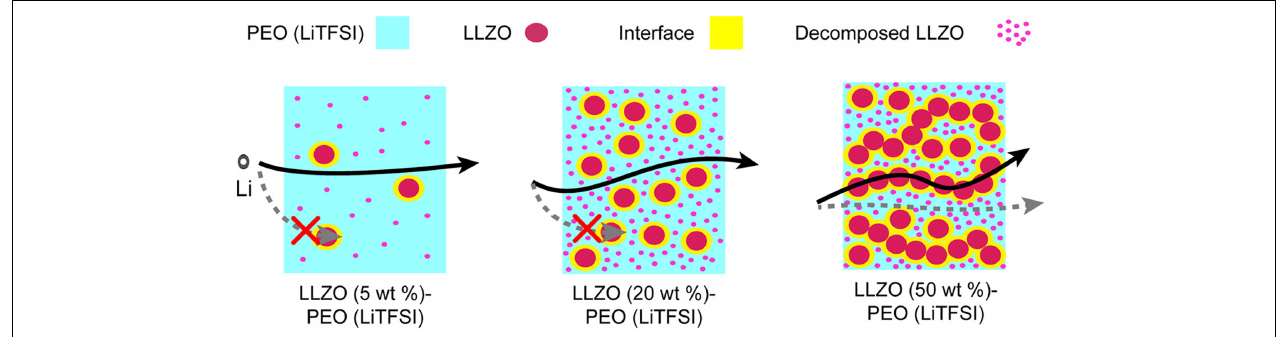
FIGURE 3 | Schematic of Li-ion pathways for PEO (LiTFSI)/LLZO with LLZO concentrations of 5 wt%, 20 wt%, and 50 wt%. Reprinted with the permission from reference Zheng and Hu (2018). Copyright 2018 American Chemical